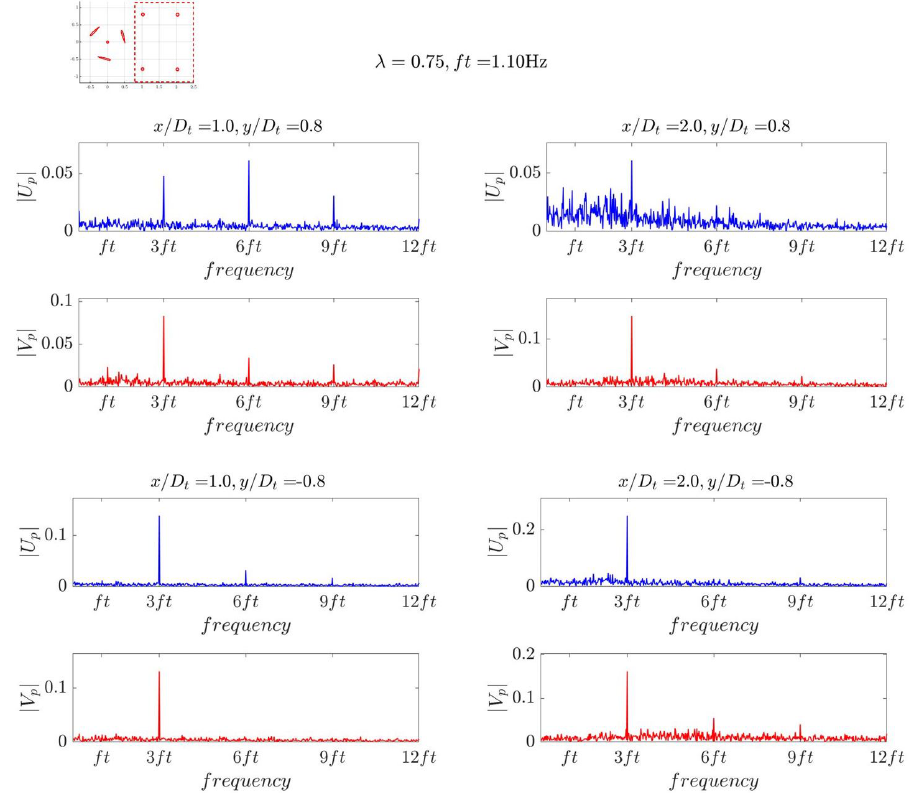
Figure 7. The FFT analyses of the time series streamwise and transverse velocities at the 4 points, highlighted in Figure 5, in the near-wake of the T1 turbine configuration at λ =